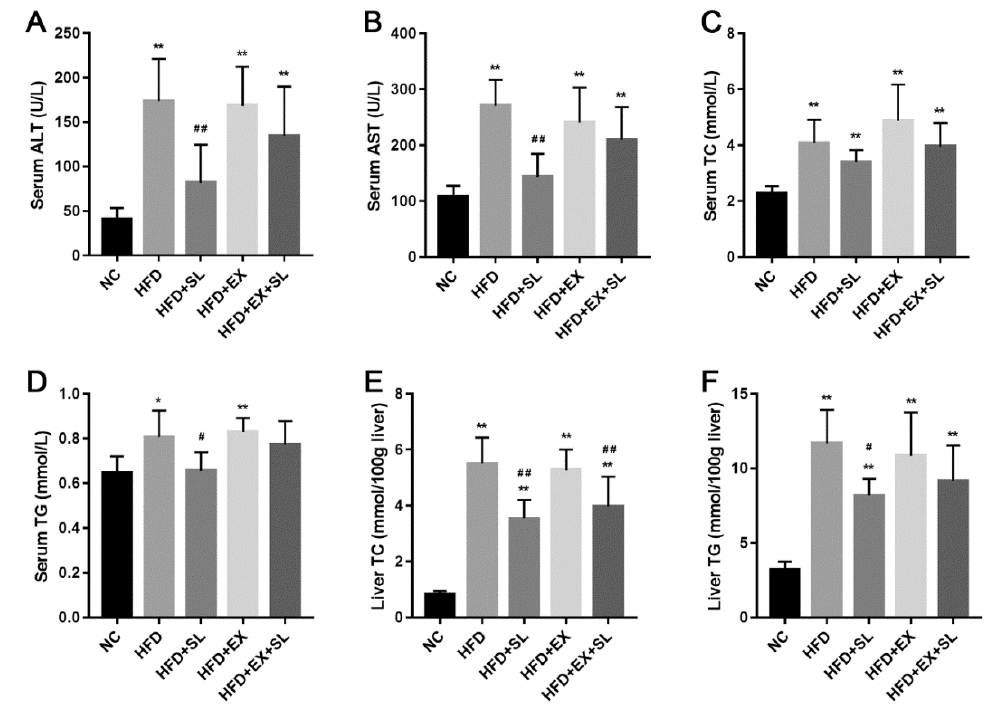
Figure 2. Biochemical parameters of the five groups. ( A ) Serum ALT level. ( B ) Serum AST level. ( C ) Serum TC level. ( D ) Serum TG level. ( E ) Liver TC level. ( F ) Liver TG level. ** p < 0.01, compared with NC group; # p < 0.05, ## p < 0.01, compared with HFD group.